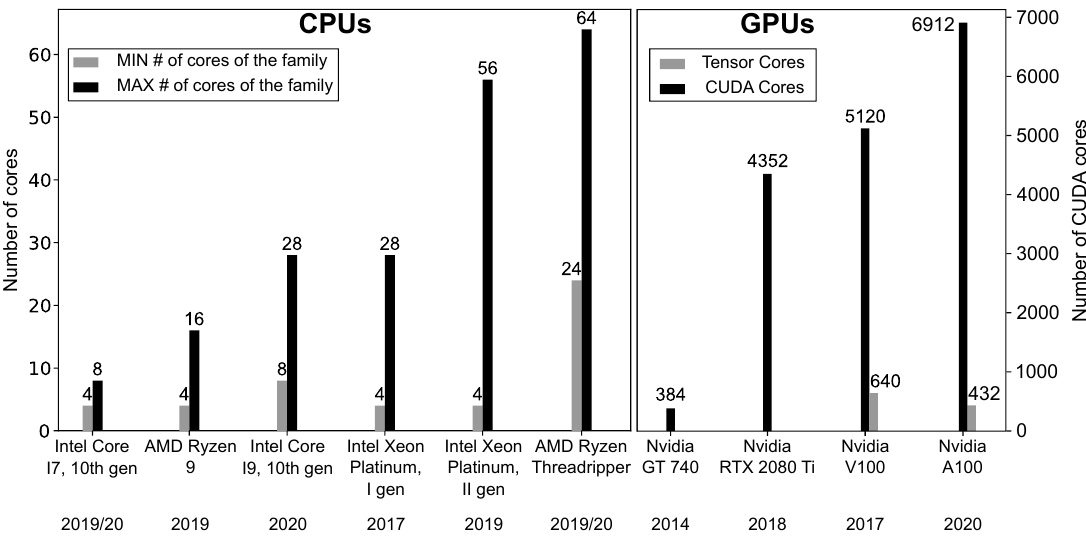
Figure 7. Comparison of the number of CPU cores and GPUs. CPUs and GPUs models have been selected for different targets, e.g., personal computers or servers, and different price ranges. For the CPUs, the gray and black lines correspond to the minimum and the maximum cores of a family, respectively. For the GPUs, the black lines represent the number of CUDA cores, and the gray line represents the Tensor cores present in the Nvidia Tesla V100